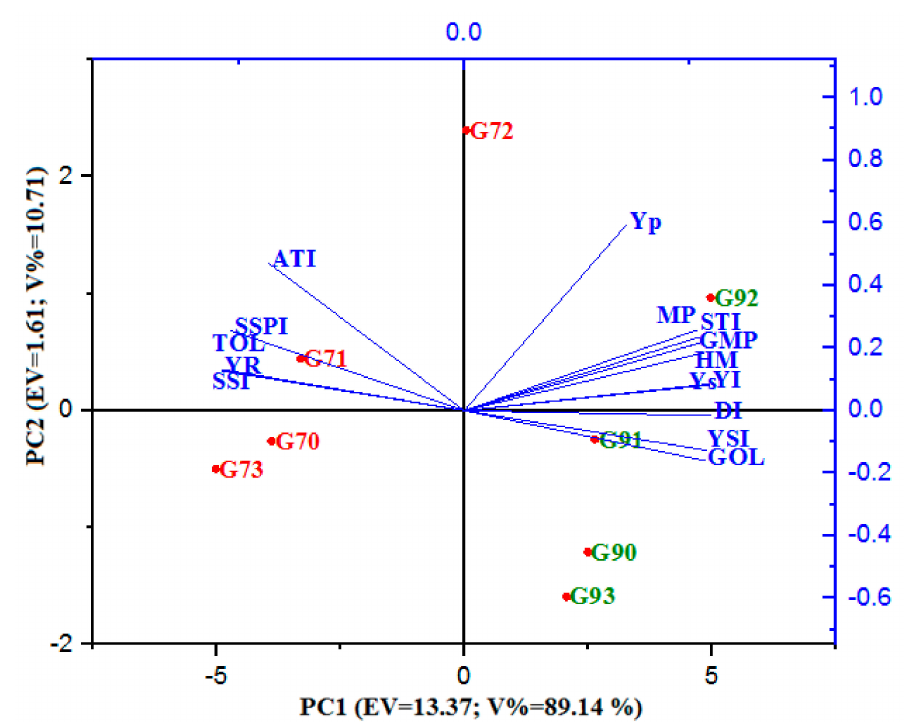
Figure 2. Biplot diagram based on principal component analysis (PC1) and PC2 shows similarities and dissimilarities in relationships among the drought indices for two rice cultivars fertilized with different salicylic acid (SA) rates based on the grain yield under normal (Yp) and drought (Ys) condi- tions; G90, G91, G92, and G93: Giza179 fertilized with 0, 400, 700, and 1000 µ M of SA, respectively; G70, G71, G72, and G73: Giza177 fertilized with 0, 400, 700, and 1000 µ M of SA, respectively. SSI: stress susceptibility index; TOL: tolerance index; MP: mean productivity; GMP: geometric mean productivity; STI: stress tolerance index; YI: yield index; YSI: yield stability index; DI: drought resistance index; YR: yield reduction ratio; ATI: abiotic tolerance index; SSPI: stress susceptibility percentage index; HM: harmonic mean; and GOL: golden